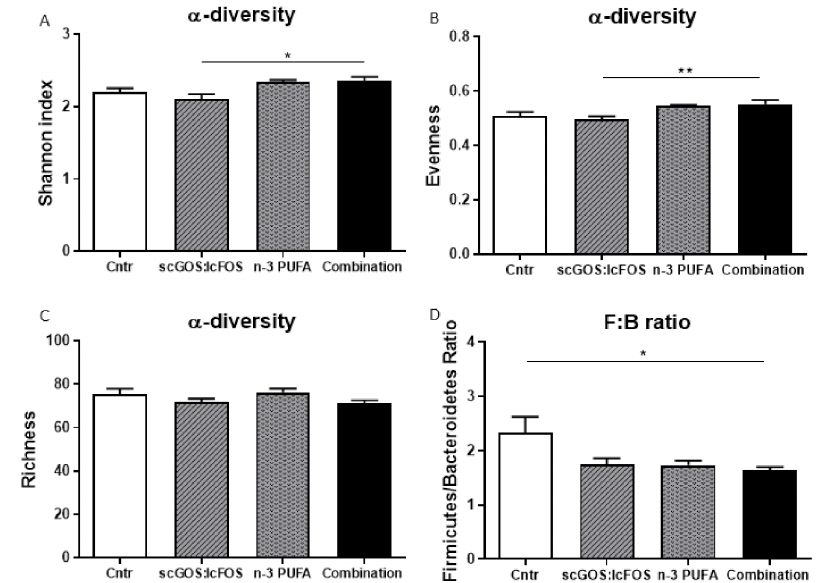
Figure 2. Caecum content alpha-diversity and Firmicutes-to-Bacteroidetes ratio for the control and dietary mice groups. Alpha-diversity indices were examined at the taxonomic level of genus. Alpha-diversity indices rarefied to 45,000 sequences per sample. Analysis of the ( A ) Shannon index and ( B ) evenness both indicated a significant dietary effect across all groups, with the combination diet diversity significantly higher than scGOS1cFOS. ( C ) Richness diversity was not significantly different across groups. At the taxonomic level of phylum, the ( D ) Firmicutes-to-Bacteroidetes ratio significantly decreased in the combination diet mice compared to the control mice. Data were square root transformed for statistics. ( A – D ): Data shown as the mean +/ − SEM. Analysed by one-way ANOVA and Sidak’s multiple comparisons post hoc test. * p < 0.05, ** p < 0.01. n = 8–10 mice per group.